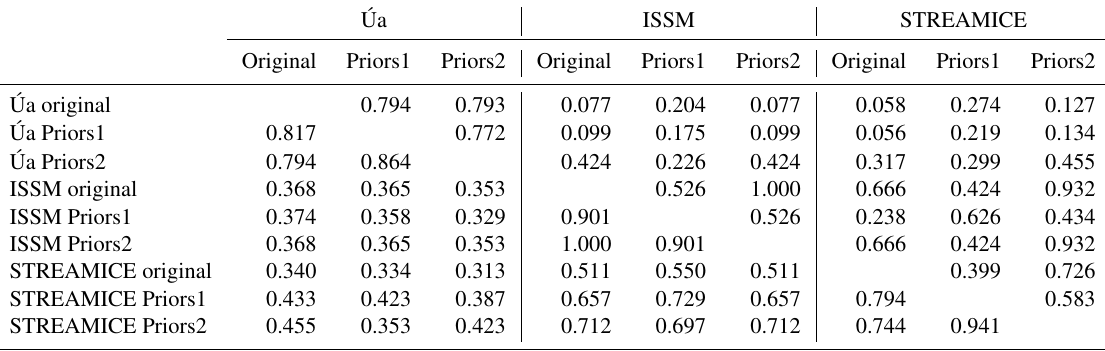
Table B2. The Pearson correlation coefficients for B between pairs of tests using different sets of priors. Above the diagonal are coefficients calculated over the entire domain. Below the diagonal are the coefficients calculated over the floating ice only.